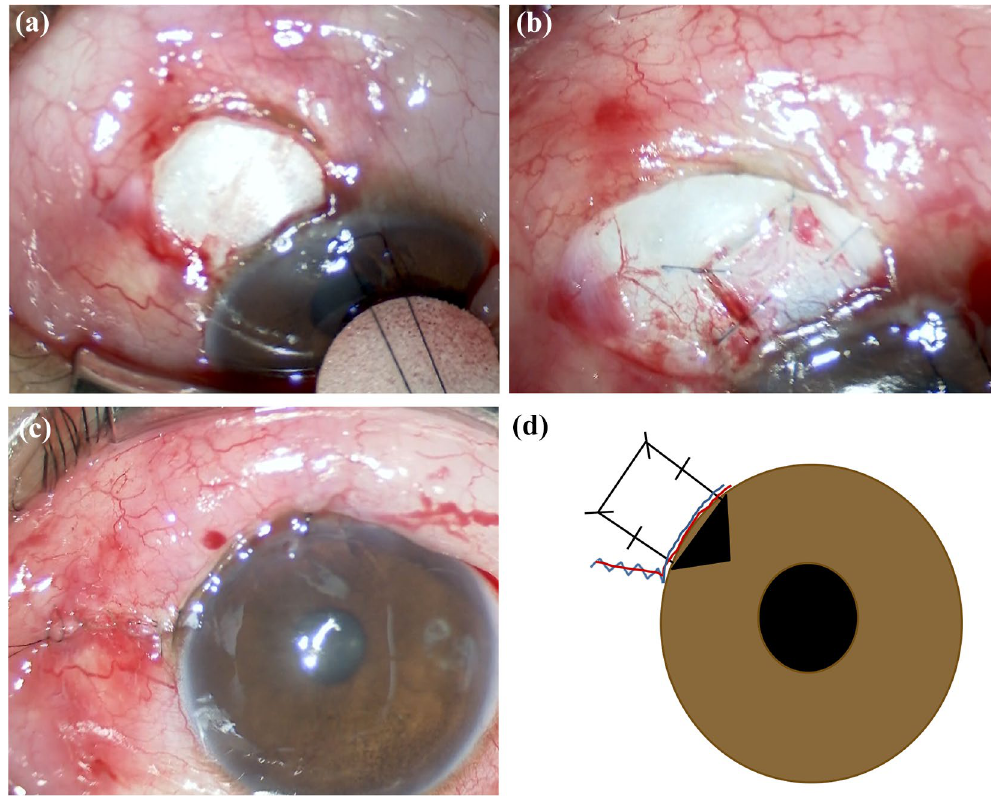
Figure 4. Procedure of trabeculectomy. Intraoperative images of trabeculectomy in this study ( a – c ) and a schema of the incision sites ( d ). A fornix-based conjunctival flap with small radial incision ( a ), a 3 × 3 mm half- layer square scleral flap formation ( b ), and suturing of the scleral flap and conjunctiva using 10–0 nylon ( c ) are performed. ( d ) Schema of the operative